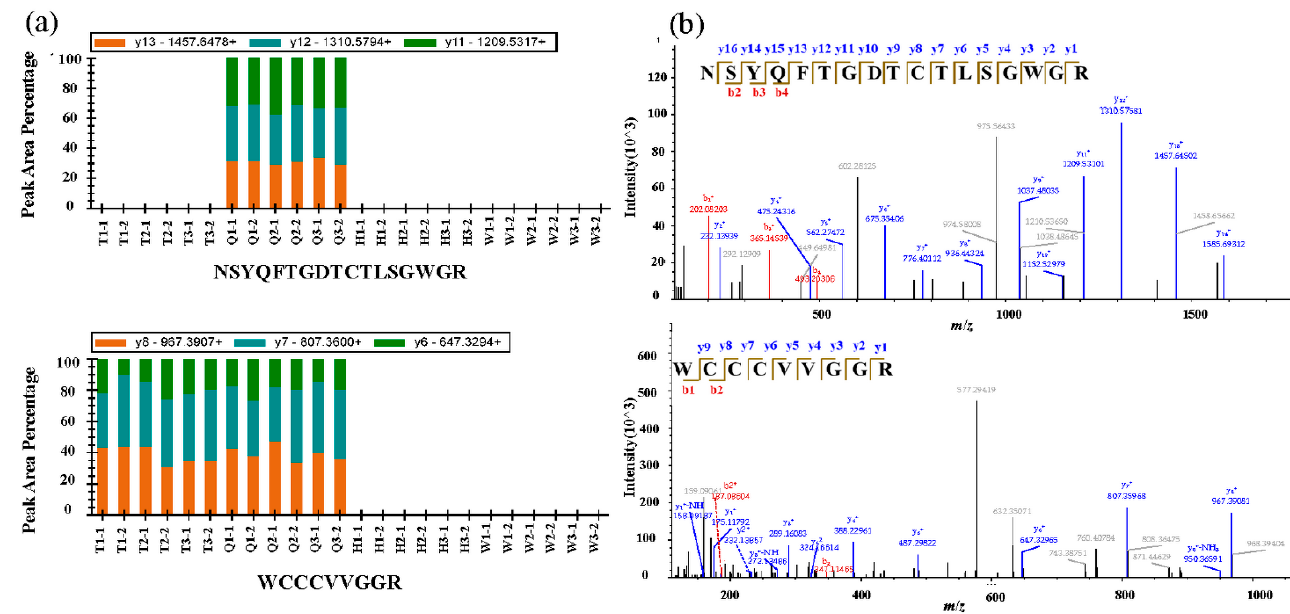
Figure 5. ( a ) The normalized peak area of marker peptides in T, Q, H, and W samples with three replicates. ( b ) MS/MS spectra for the target marker peptides taking peptides NSYQFTGDTCT- cates. ( b ) MS/MS spectra for the target marker peptides taking peptides LSGWGR and WCCCVVGGR as examples (the meanings of T, Q, H, and W are the same with those